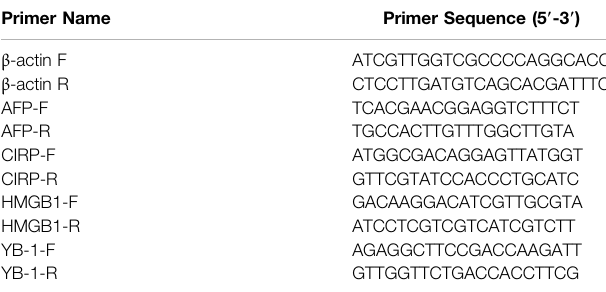
TABLE 1 | Primers of AFP, CIRP, HMGB1, YB-1, and β -actin used for